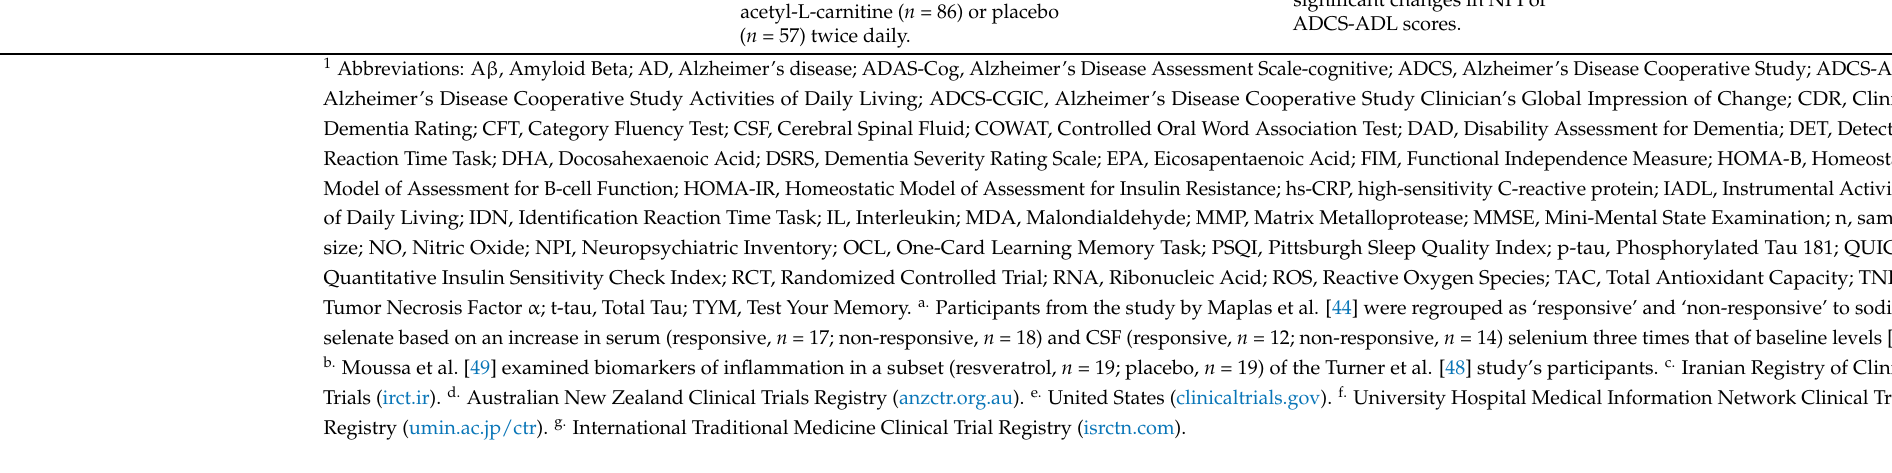
Alzheimer’s Disease Cooperative Study Activities of Daily Living; ADCS-CGIC, Alzheimer’s Disease Cooperative Study Clinician’s Global Impression of Change; CDR, Clinical Dementia Rating; CFT, Category Fluency Test; CSF, Cerebral Spinal Fluid; COWAT, Controlled Oral Word Association Test; DAD, Disability Assessment for Dementia; DET,